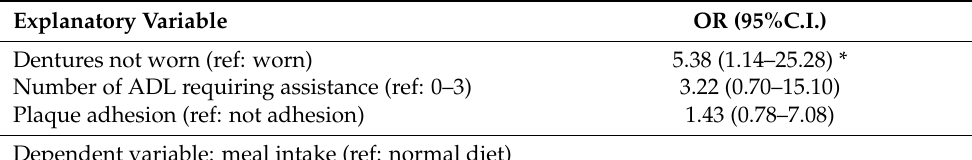
Table 6. Results of logistic regression analyses for meal